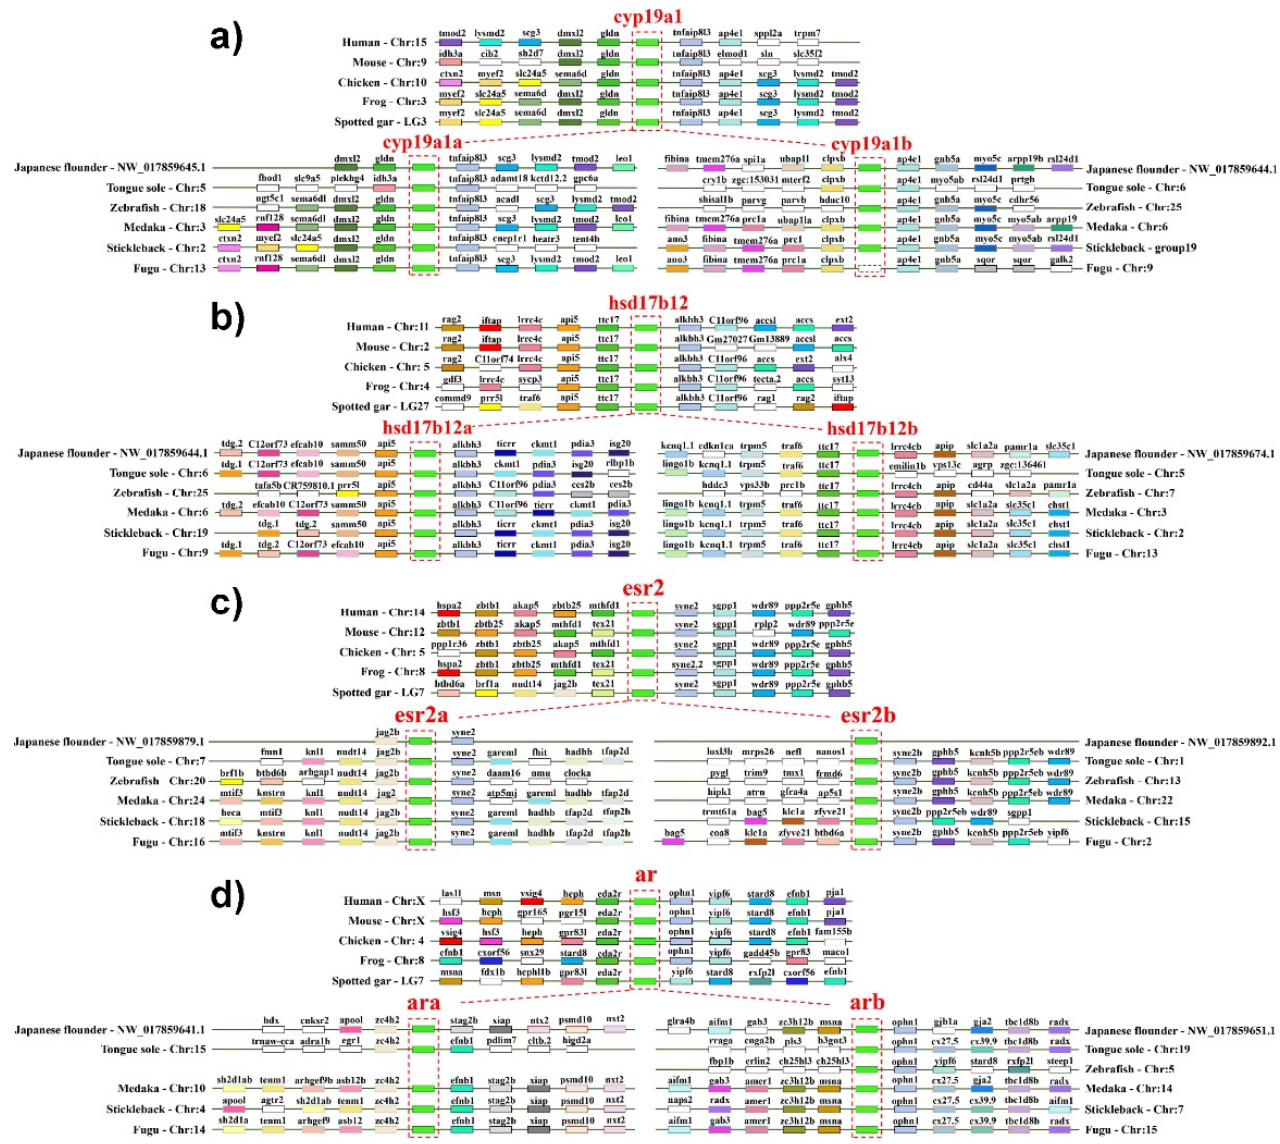
Figure 3. Synteny analysis of putatively duplicated steroidogenic genes between teleost and tetrapod lineages according to the TSGD, as ( a ) cyp19a1, ( b ) hsd17b12, ( c ) esr2 and ( d ) ar. Genes were shown as colored boxes with their names on top. The boxes with the same color were orthologous among different species.